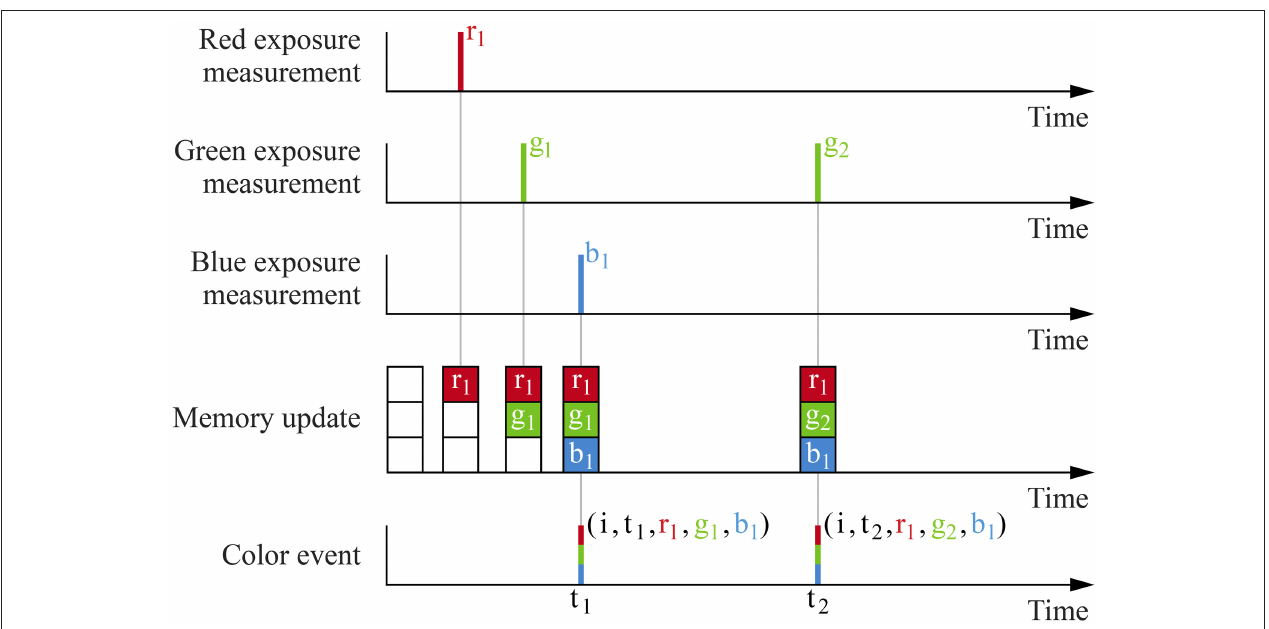
FIGURE 4 | Events generated by the color sensor’s three cameras’ pixel i are merged to generate color events. Every time an exposure measurement is generated by one of the ATIS cameras, it is stored in memory. Then, a color event is dispatched using the current memory value.